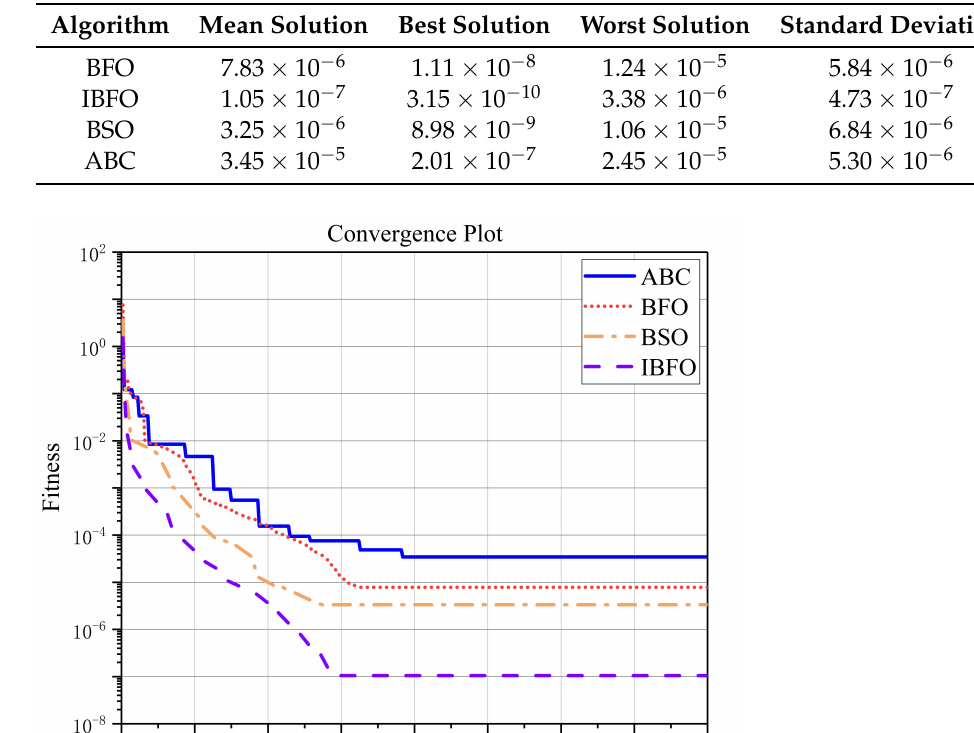
Table 3. Comparative performance of BFO, BSO, IBFO, and ABC.